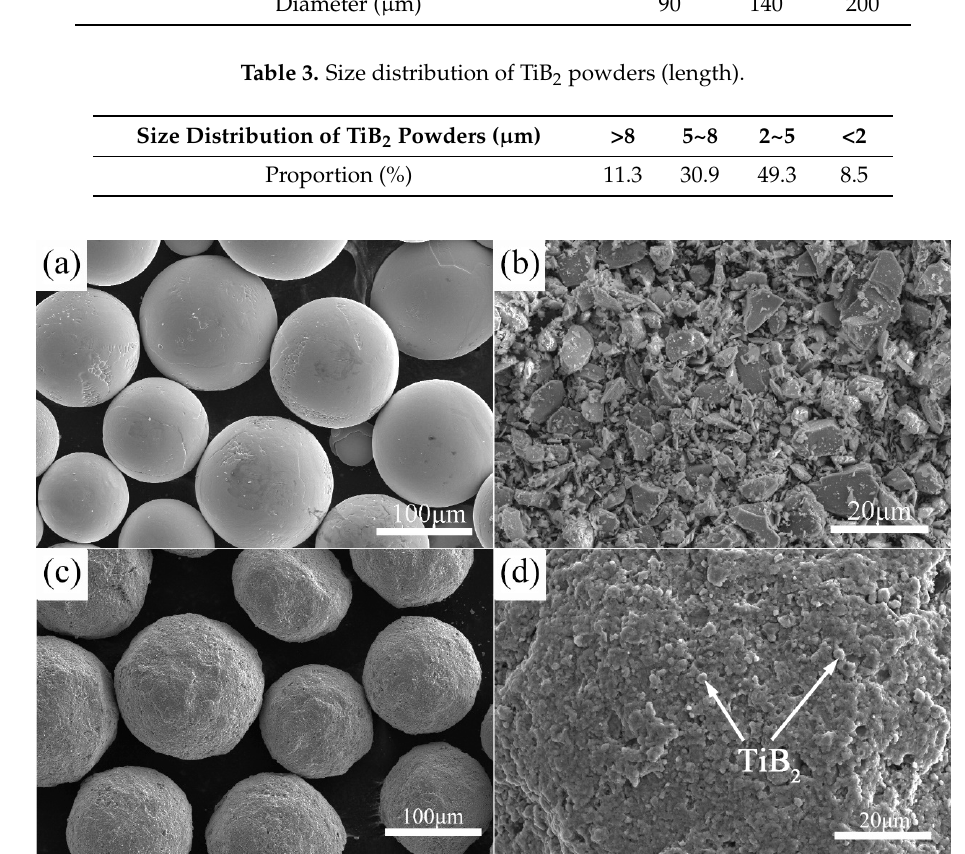
Table 2. Size distribution of TA15 powders (diameter).